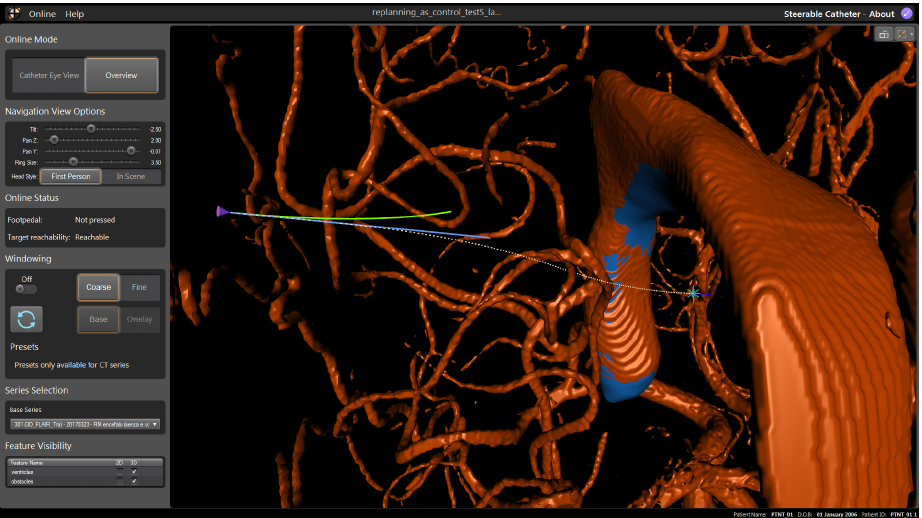
Figure 7. Path 2 shown with the virtual overlays in Overview